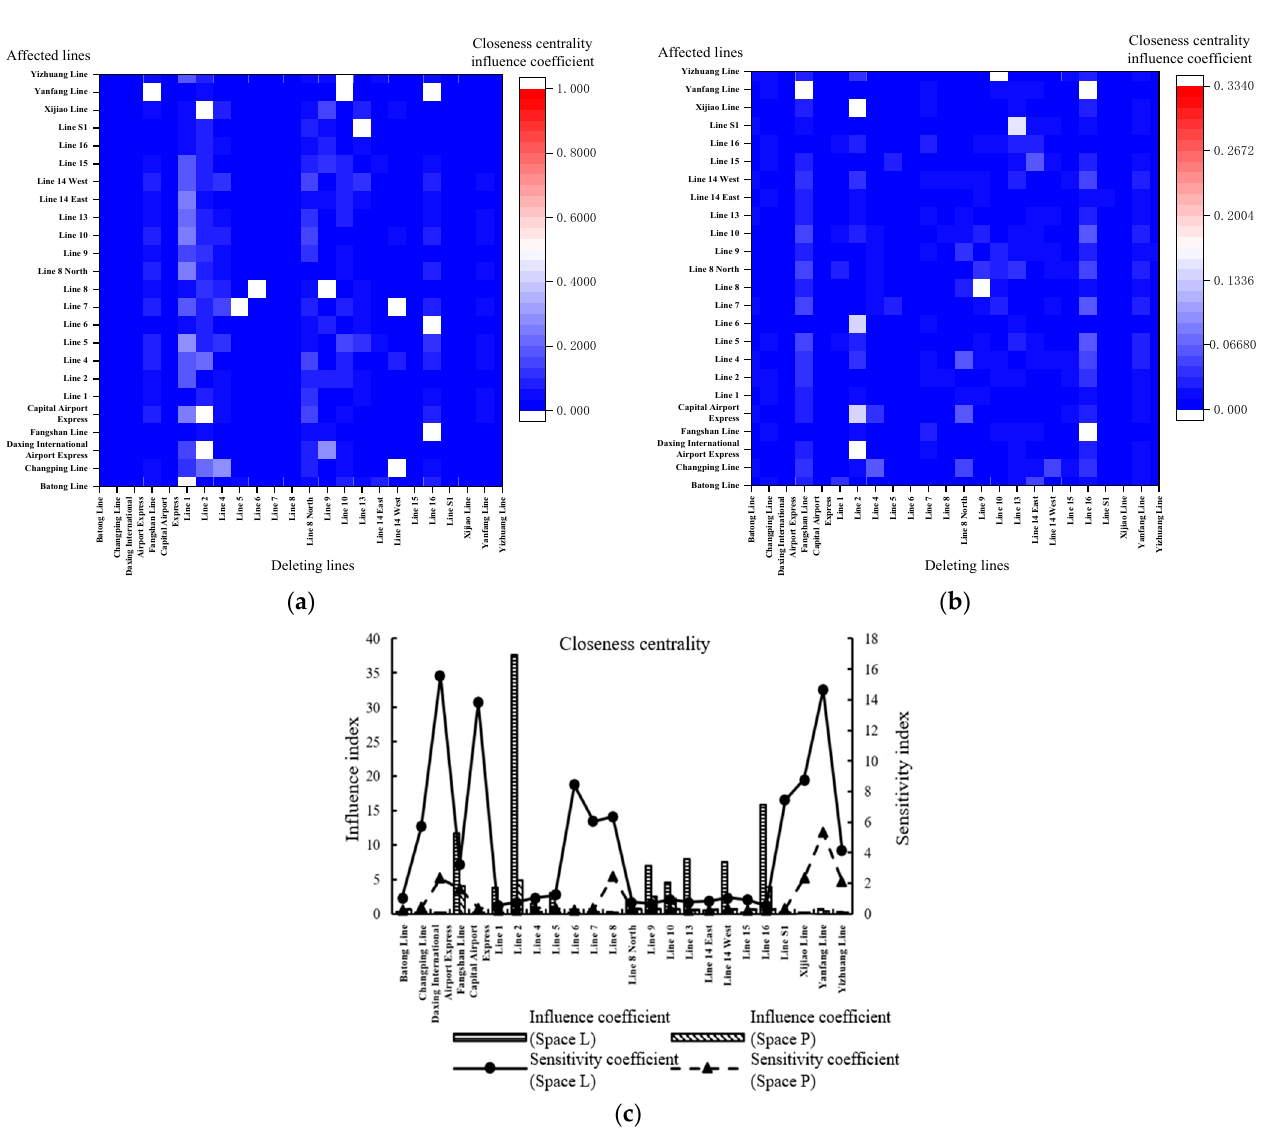
Figure 9c: Line 10, Line 9, and Line 2 have the highest near-centrality influence coefficient under the Space L and Space P. Daxing International Airport Express and Yanfang Line have the highest near-centrality sensitivity coefficient.